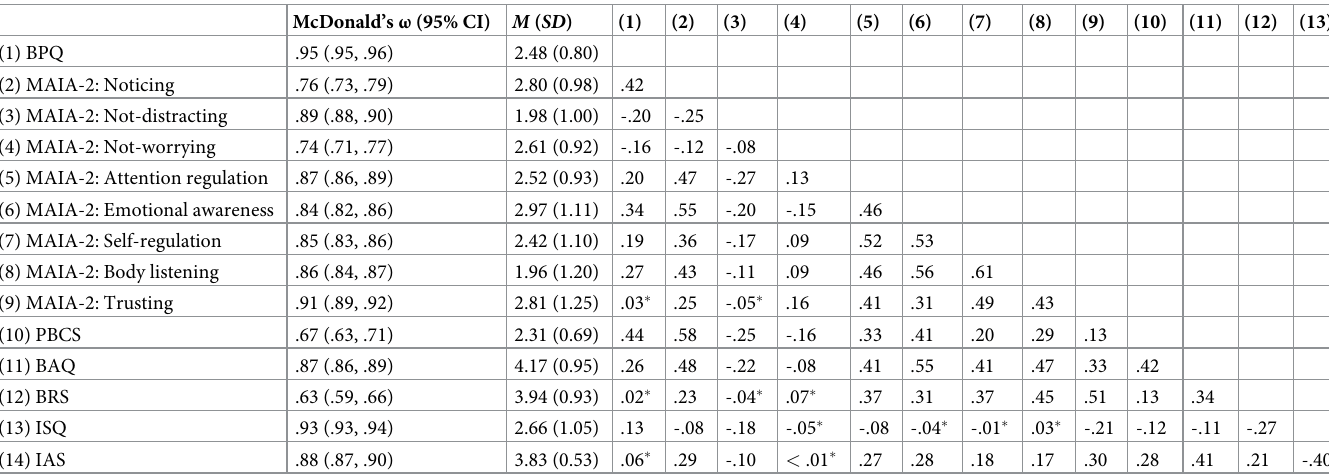
Table 2. Internal consistency coefficients, descriptive statistics, and inter-correlations between scores on all measures included in the present